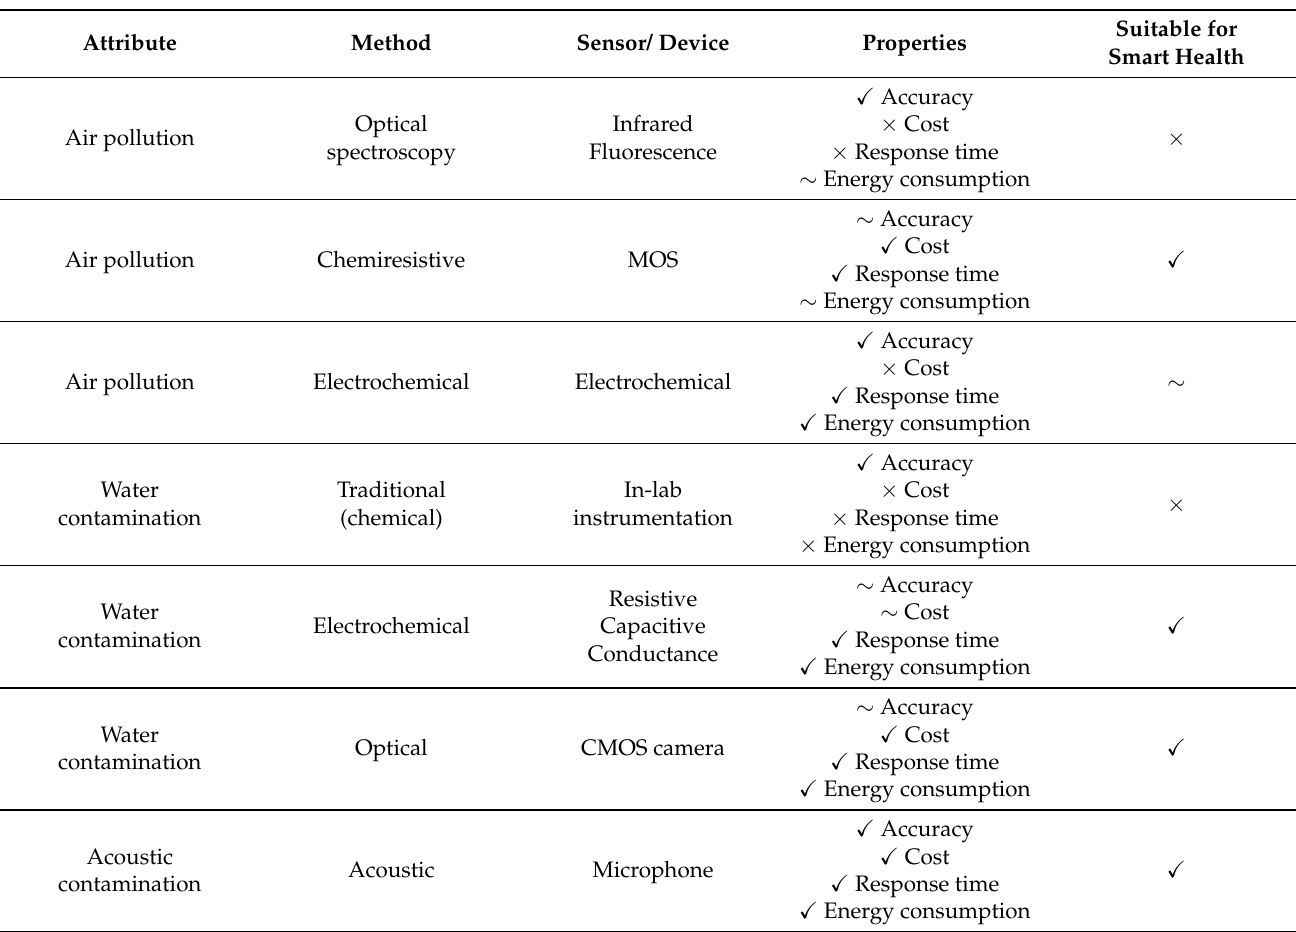
Table 9. Characteristics of the methods for air pollution sensing, water contamination sensing and acoustic contamina- tion